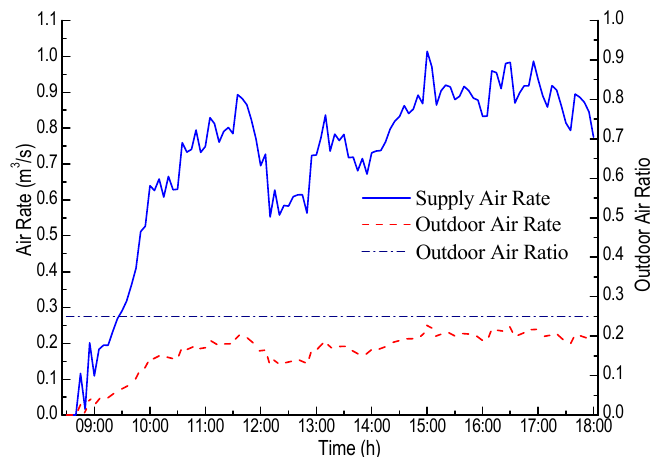
Figure 5. Supply air rate of six zones under Scenario 1.